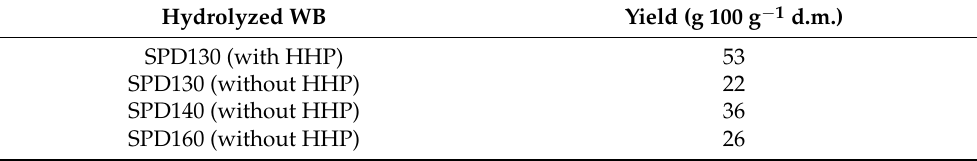
Data are mean values ± standard deviation of two replicates. Abbreviations: hydrolyzed WB spray-dried at 130 ◦ C (SPD130), 140 ◦ C (SPD140), or 160 ◦ C (SPD160), HHP (high hydrostatic